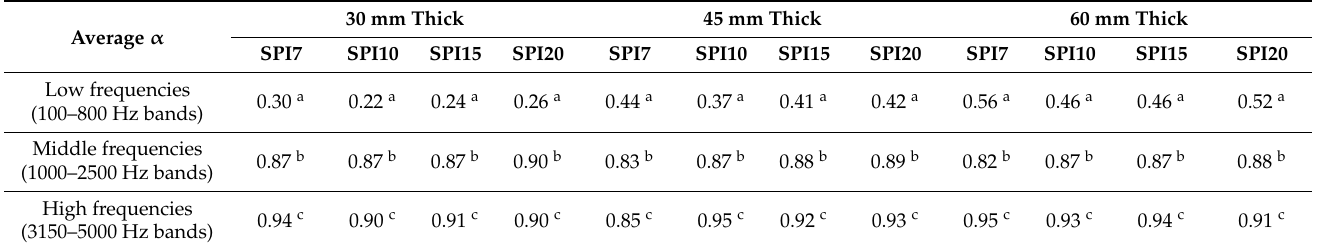
Table 1. Average and standard deviation of sound absorption coefficients at normal incidence ( α ) for SPI7, SPI10, SPI15, and SPI20 biocomposites at low, middle, and high frequency bands. Average α